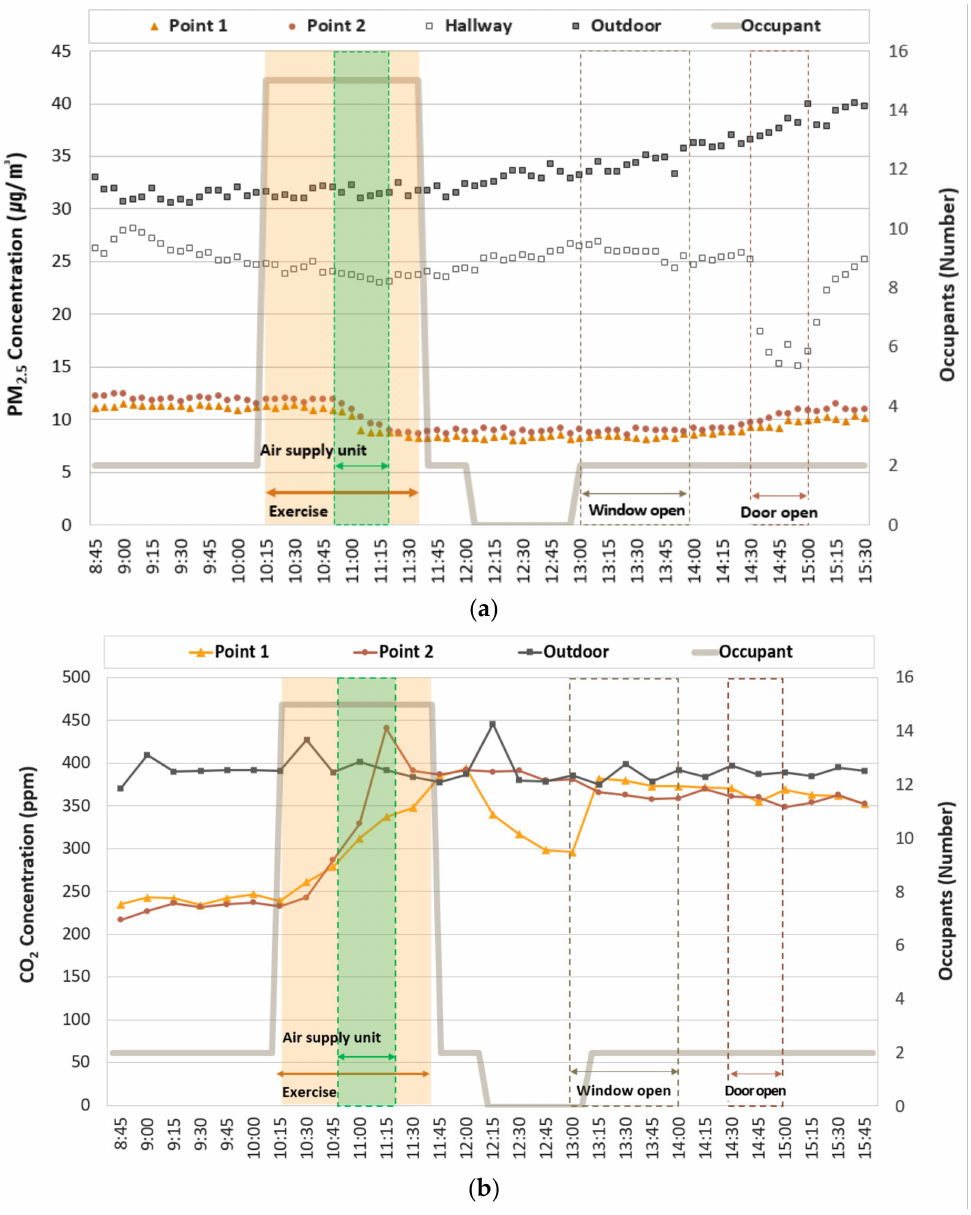
Figure 7. PM 2.5 and CO 2 concentration test results for 616.14 m 2 multipurpose activity space on 18 November 2021. ( a ) PM 2.5 concentration. ( b ) CO 2